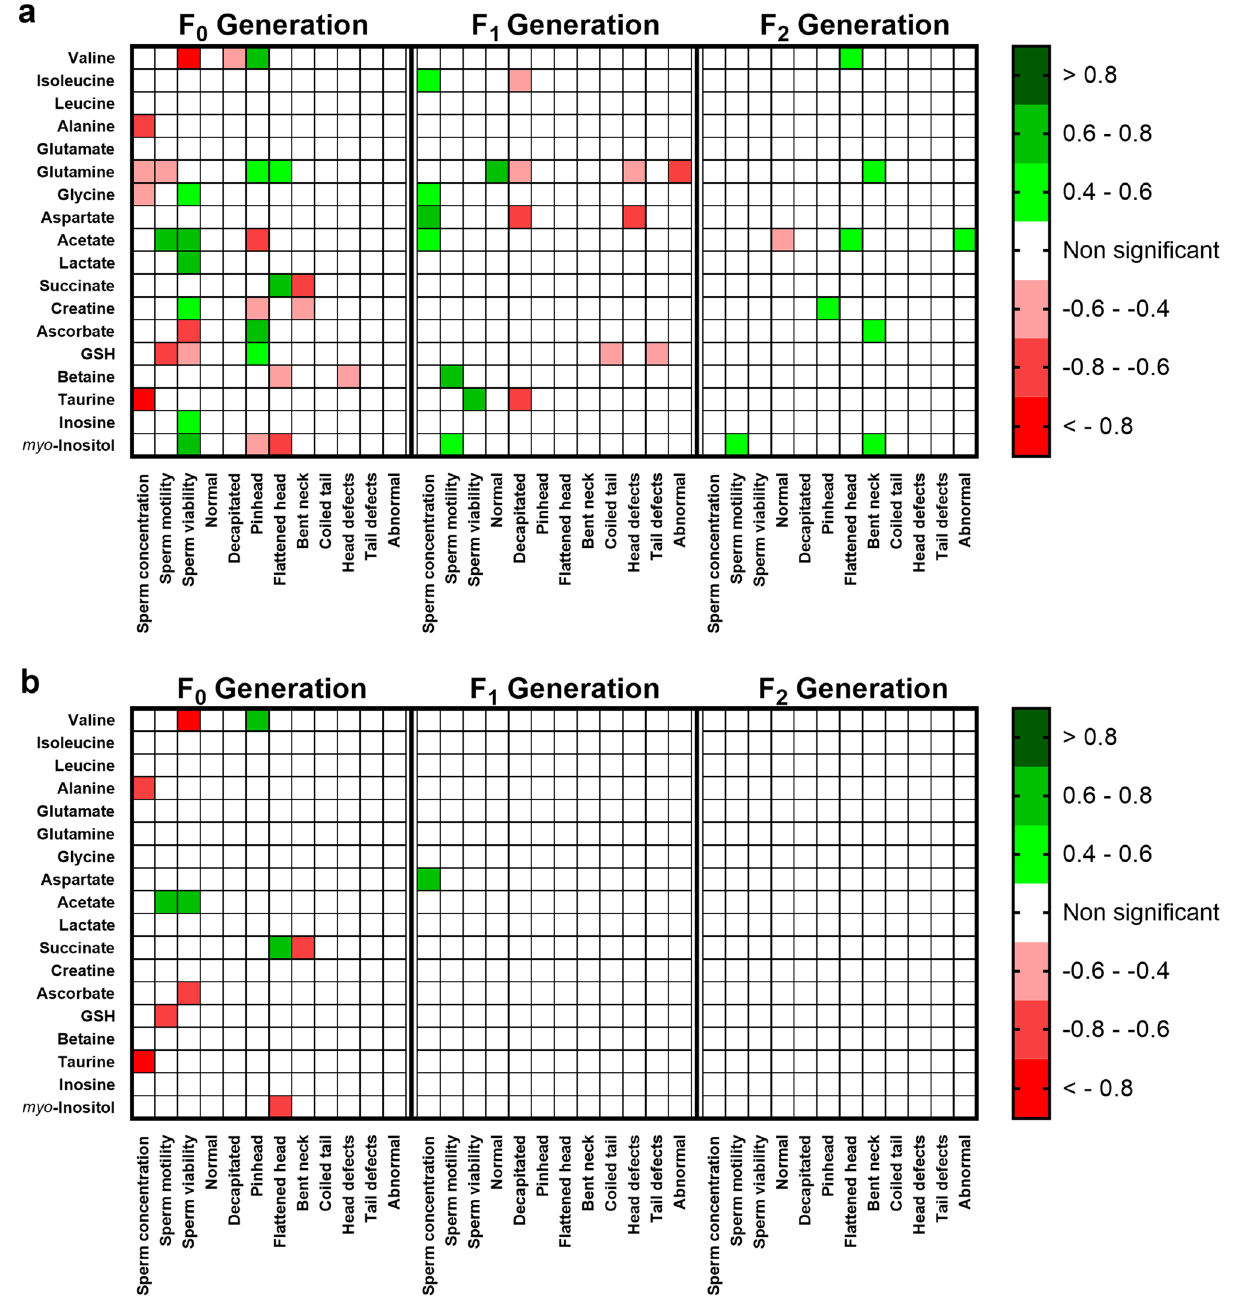
Figure 5. Correlations between sperm parameters and testicular metabolites, in each generation of the study (n = 6 per group in each generation). Correlation factors were obtained by Pearson’s method using SPSS 26 (Armonk, NY, USA). ( a ) Strong (|r|> 0.4) and significant correlations considering unadjusted two-tailed p < 0.05. ( b ) Strong (|r|> 0.4) and significant correlations considering FDR-adjusted p < 0.1. Heatmaps were obtained using the software GraphPad Prism 8 (San Diego, CA,